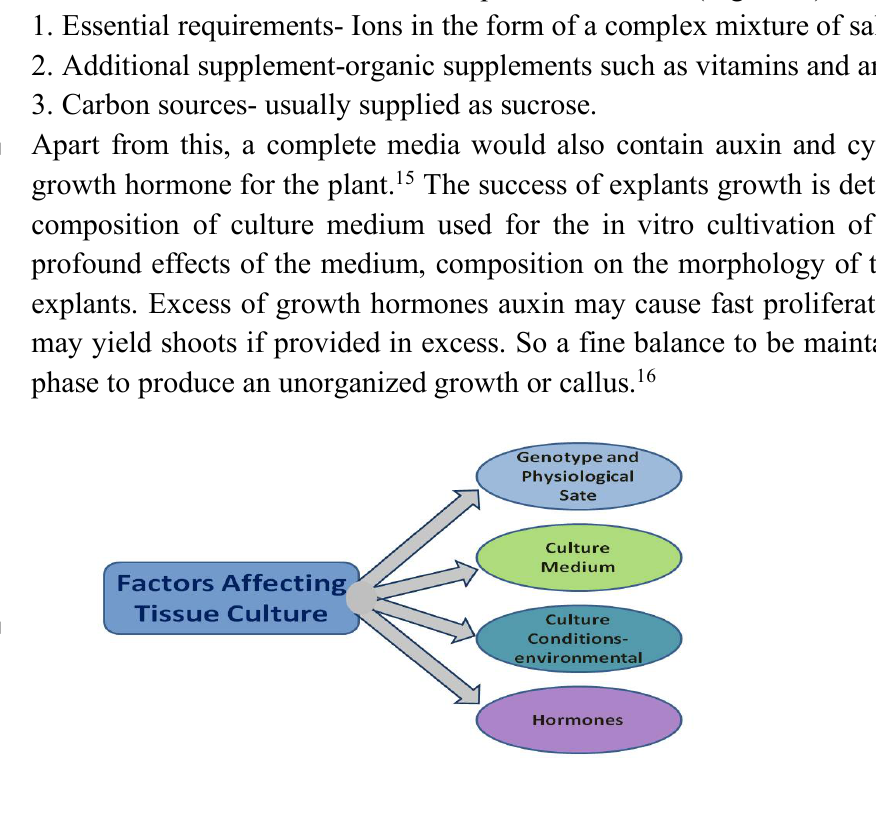
Figure 1: Basic requirement of plant tissue